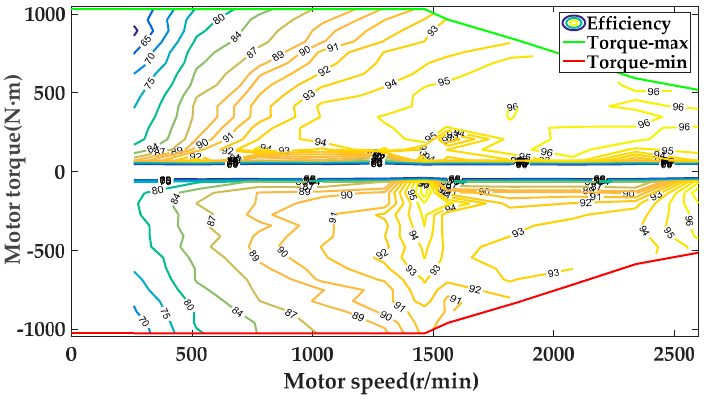
Figure 3. Motor e ffi ciency Figure 3 . Motor efficiency map